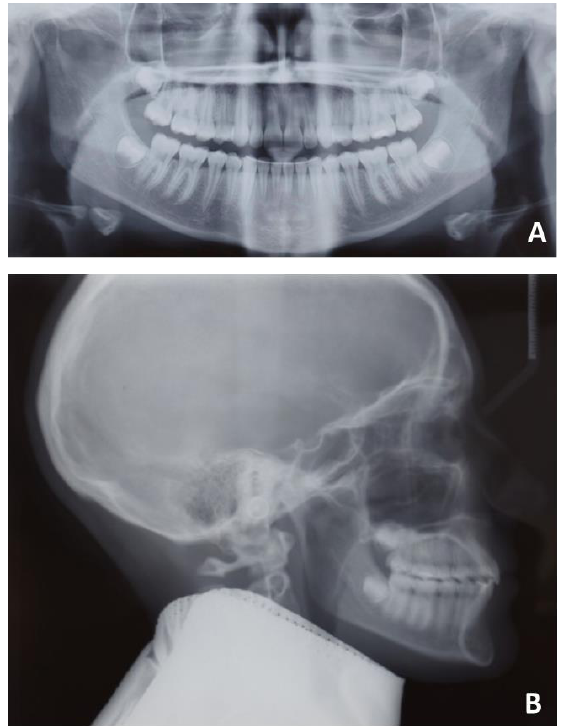
Figure 19. Post-treatment radiographic of case number 2: ( A ) orthopantomography; ( B ) lateral cephalogram.